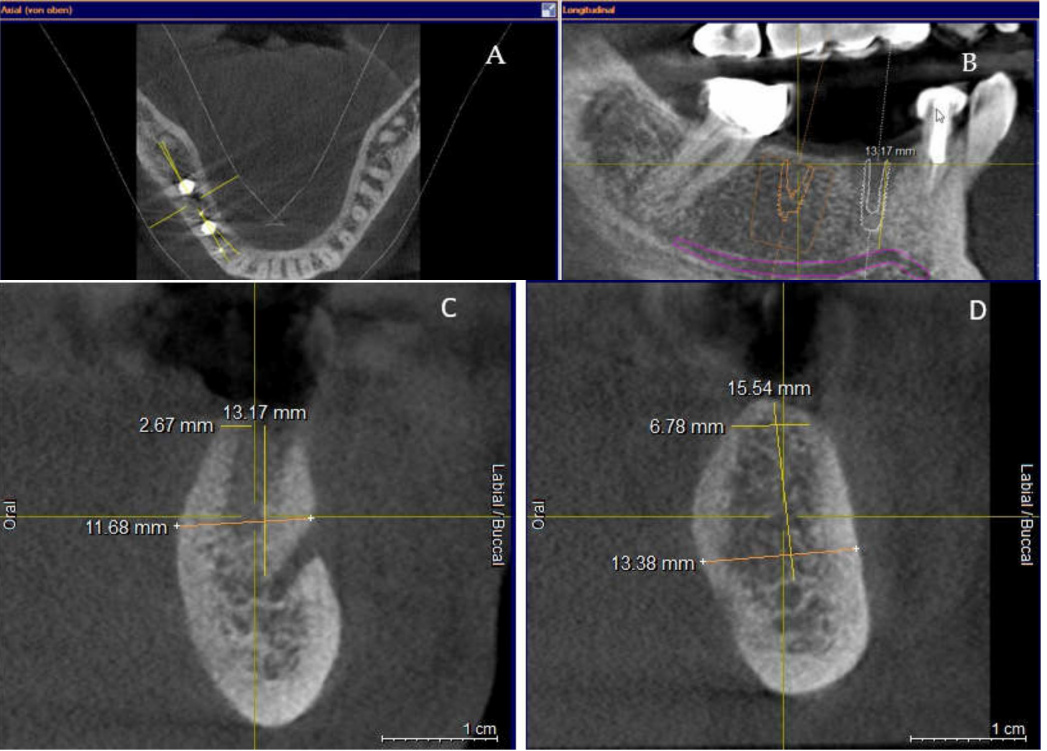
Figure 1. ( A , B ) Pre-operative CBCT aspects. ( A ) Narrow residual alveolar ridge. ( B ) Analysis of the mandibular nerve position. ( C , D ) Pre-operative CBCT aspects (cross-sectional).